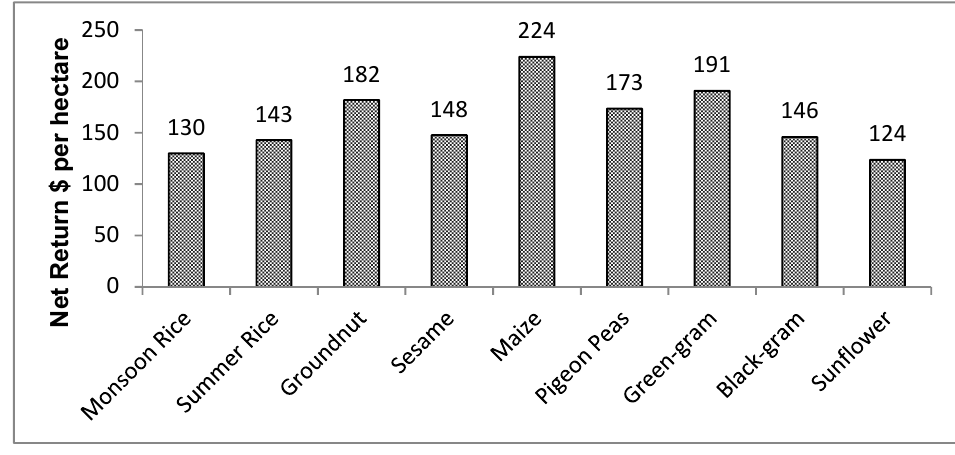
Figure 2. Farm revenue of crops ($) per hectare.